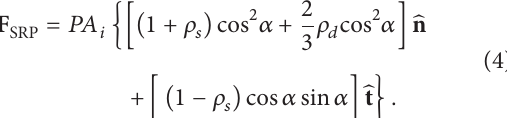
oriented surface such that the acceleration experienced by the surface is a function of the surfaces attitude. The variation of the solar radiation pressure with solar distance can be approximated by an inverse square variation